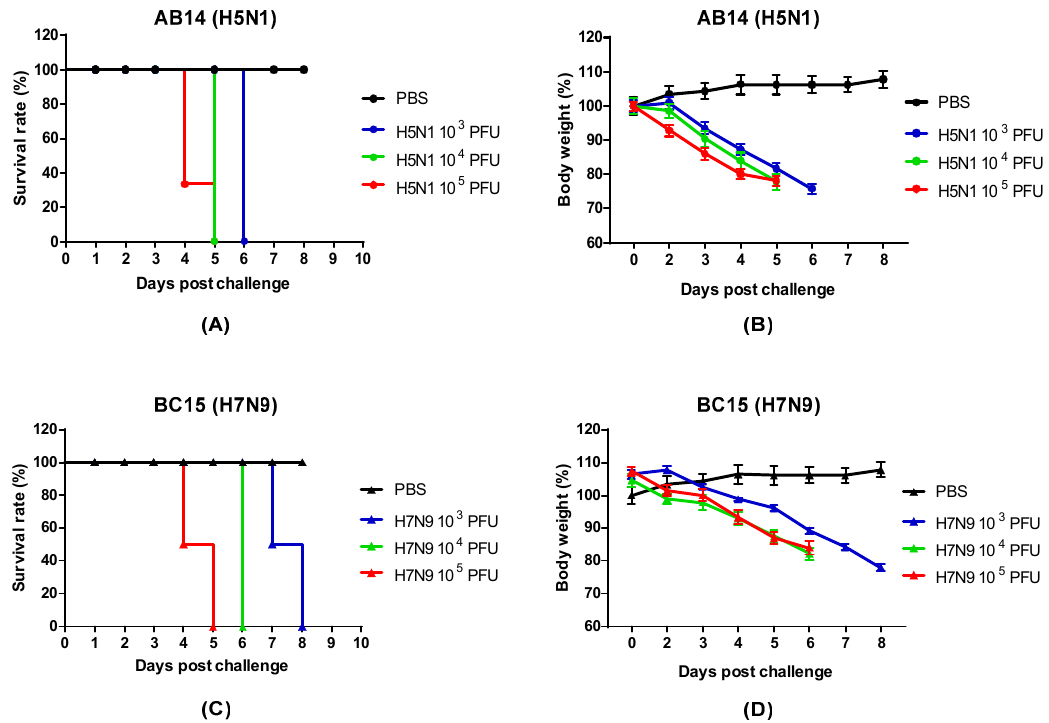
Figure 1. Survival rate and body weight loss for the AB14 (H5N1) and BC15 (H7N9) strain isolates. The survival rates for ( A ) AB14 (H5N1) and ( C ) BC15 (H7N9) as well as body weight changes for ( B ) AB14 (H5N1) and ( D ) BC15 (H7N9) were determined in BALB/c mice ( n = 6 per group) infected with 10 3 PFU, 10 4 PFU, and 10 5 PFU of the two different strain isolates.